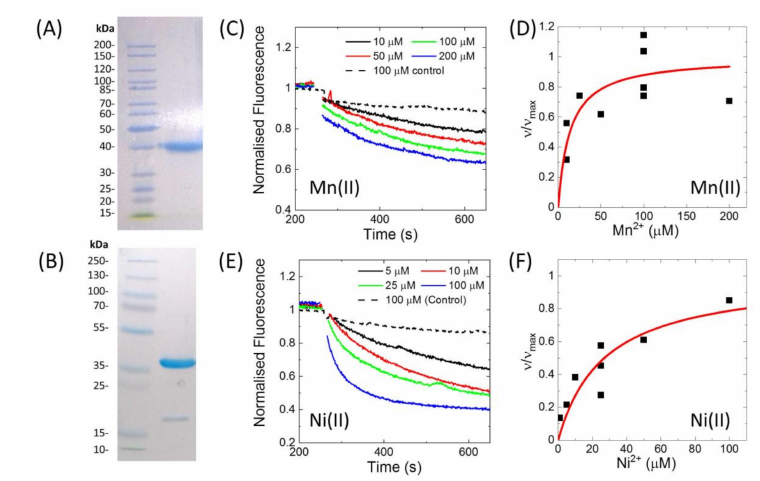
Figure 2. ( A ) SDS-PAGE gel of the purified, his-tagged MntH2. ( B ) SDS-PAGE gel of MntH2 after the his-tagwasremovedbytreatmentwithHRV-3Cprotease.Theimpurityat~18kDaisbelievedtobeHRV-3C protease, which was not completely removed by IMAC chromatography. ( C , E ) Concentration-dependent quenching of calcein in metal uptake assays. Calcein dye was encapsulated into proteoliposomes with his-tagged MntH2 at LPRs of ( C , D ) 70:1 or (E, F) 110:1 ( w / w ). Metals were added at ~250 s. The dashed lines are control experiments using liposomes without MntH2. ( D , F ) Initial velocities of metal uptake were determined by a linear fit of the first 20 s of the traces measured in three different MntH2 proteoliposomes samples and plotted against metal concentration (black squares) and fitted with a Michaelis–Menten model using non-linear regression (red line). The uptake rates ( υ ) are normalised against maximum uptake rates ( υ max ) determined from the fit. The K Mapp for Mn(II) and Ni(II) was ~15 µ M. Experiments are performed in 5 mM MOPS, pH 7.0, 150 mM